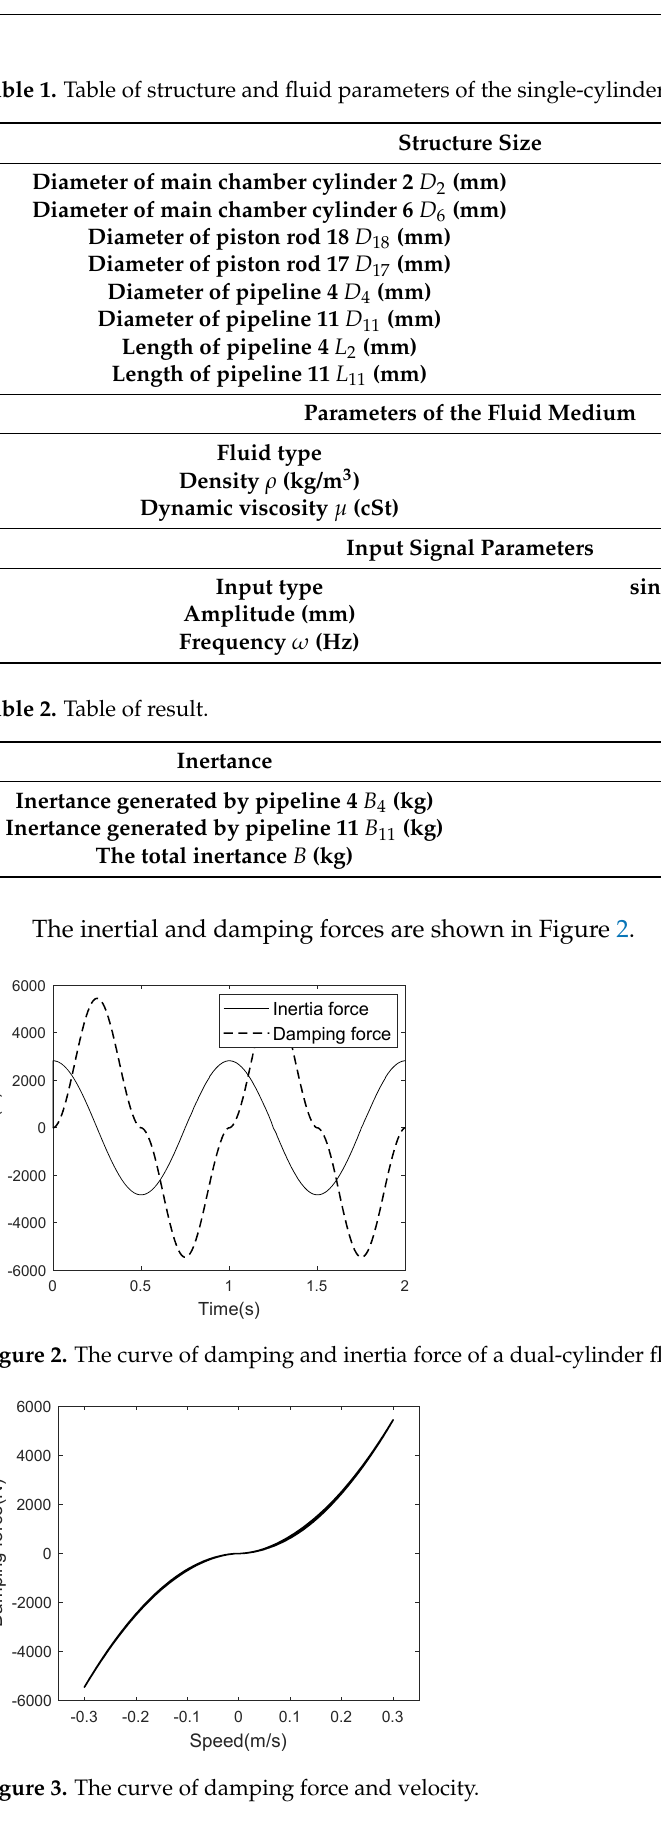
Figure 3. The curve of damping force and velocity.